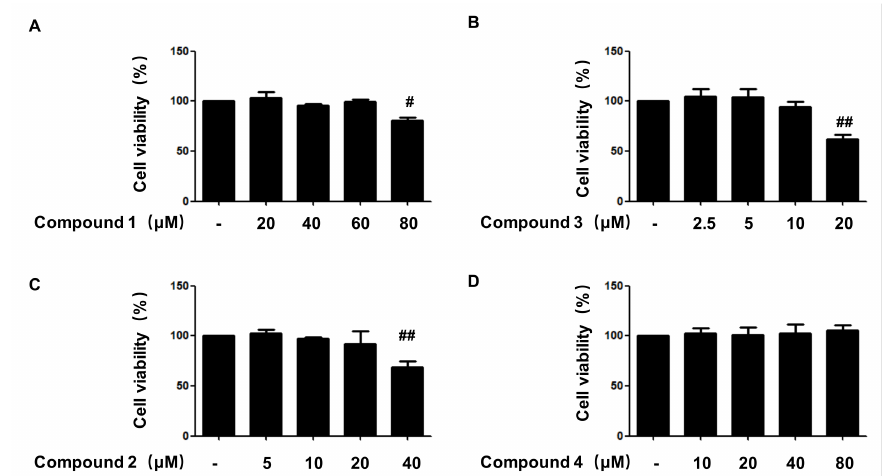
Figure 2. Cytotoxicity of the compounds 1 ( A ), 2 ( C ), 3 ( B ), and 4 ( D )used in this study. Cytotoxicity was evaluated in cells treated for 24 h with indicated concentration of 4 compounds. Data are presented as the mean ± SD values of 3 independent experiments. # p < 0.05, ## p < 0.01, vs. control.